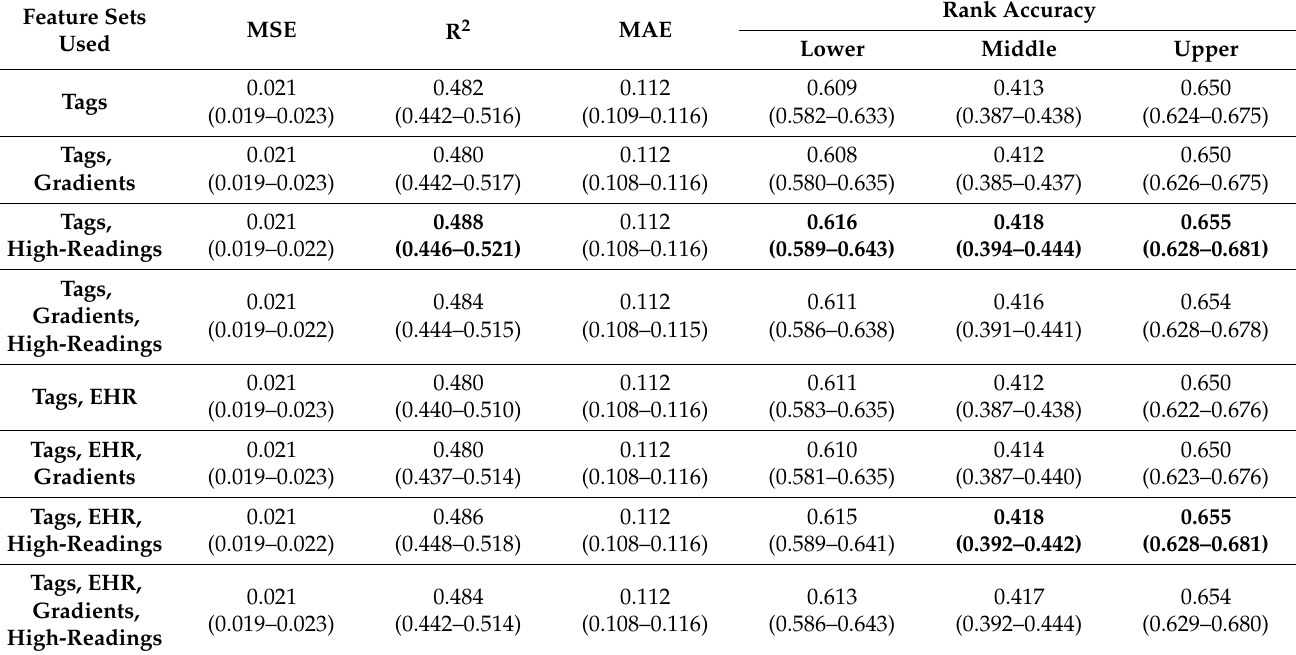
Table 5. Overall performance and rank accuracy of XGBoost models trained on different feature set combinations. Results are reported alongside 95% confidence intervals (calculated using 1000 boot- strap